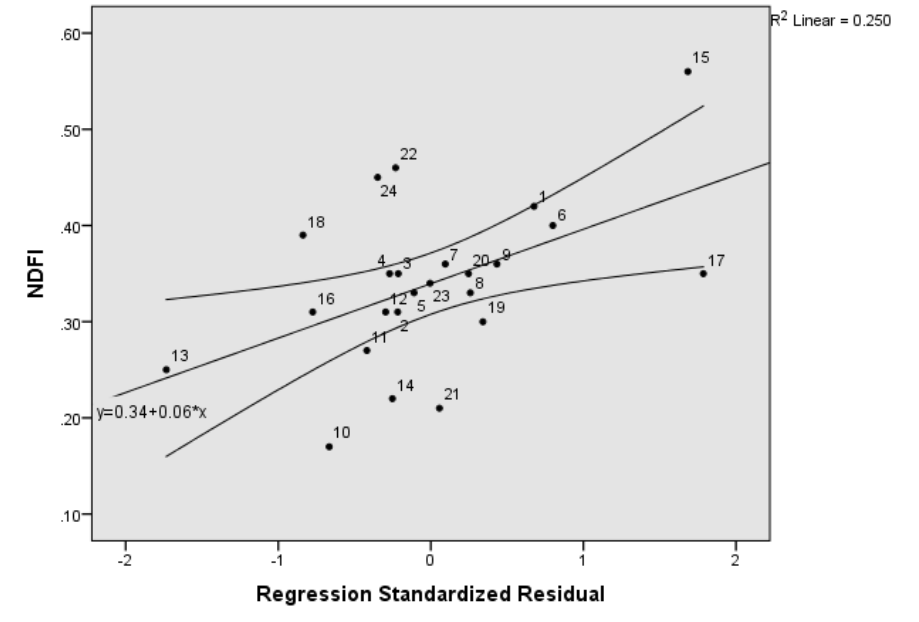
Figure 52. Relationship between regression ZRE and NDFI2.